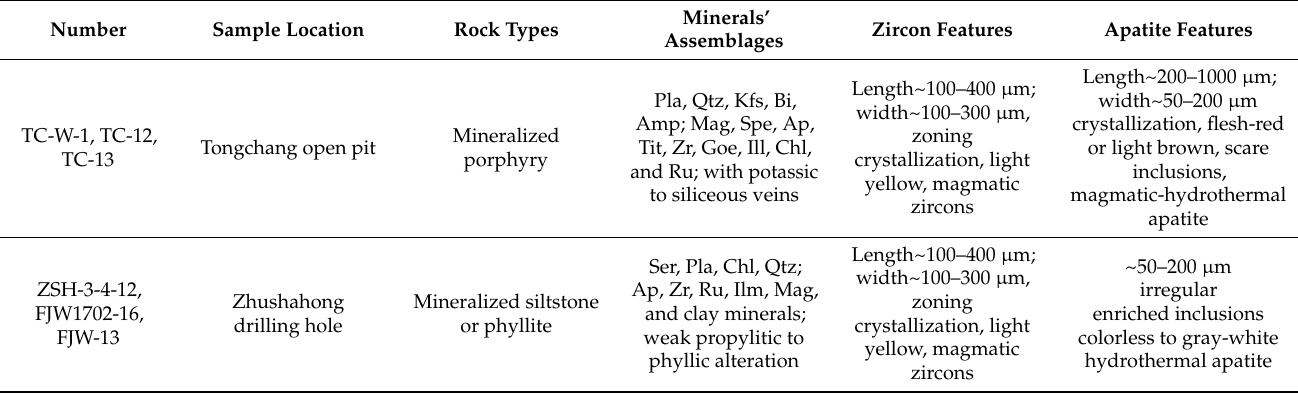
Table 1. Six samples detail information and features of zircon and apatite grains under